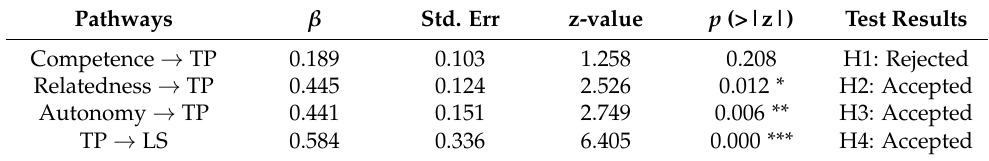
Table 6. Summary of the Proposed